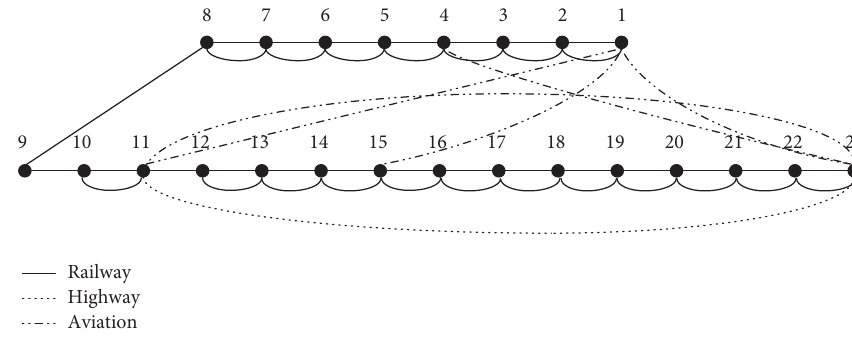
Figure 1: Multimodal transport network map in Sichuan–Tibet region.